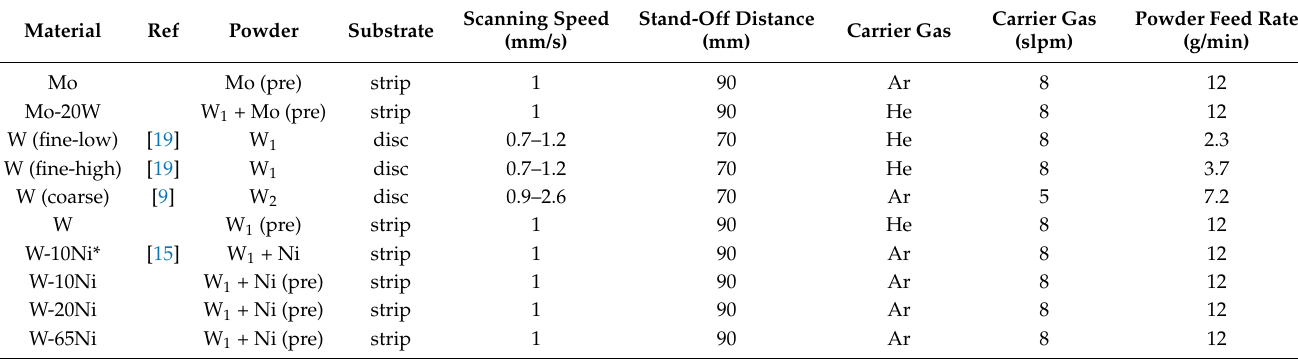
Table 2. Most important RF-ICP deposition parameters of the investigated materials. The nominal powder blend compositions are given in wt.%. Feedstocks denoted “(pre)” were pre-treated in reductive atmosphere before their